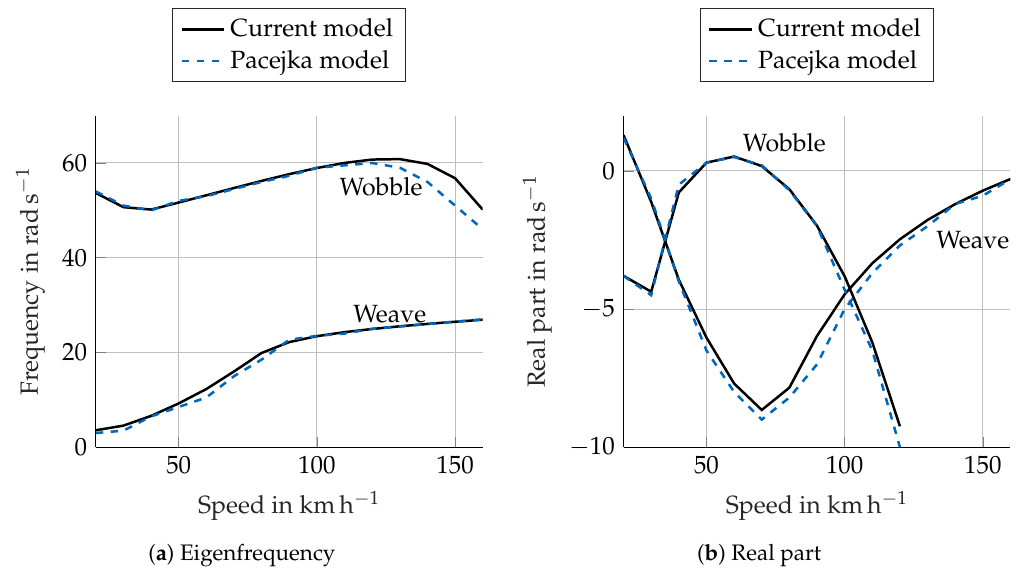
Figure 3. Model validation with eigenvalue analysis: comparison between the current model (parametrised with the same data of the Pacejka model) and the model of